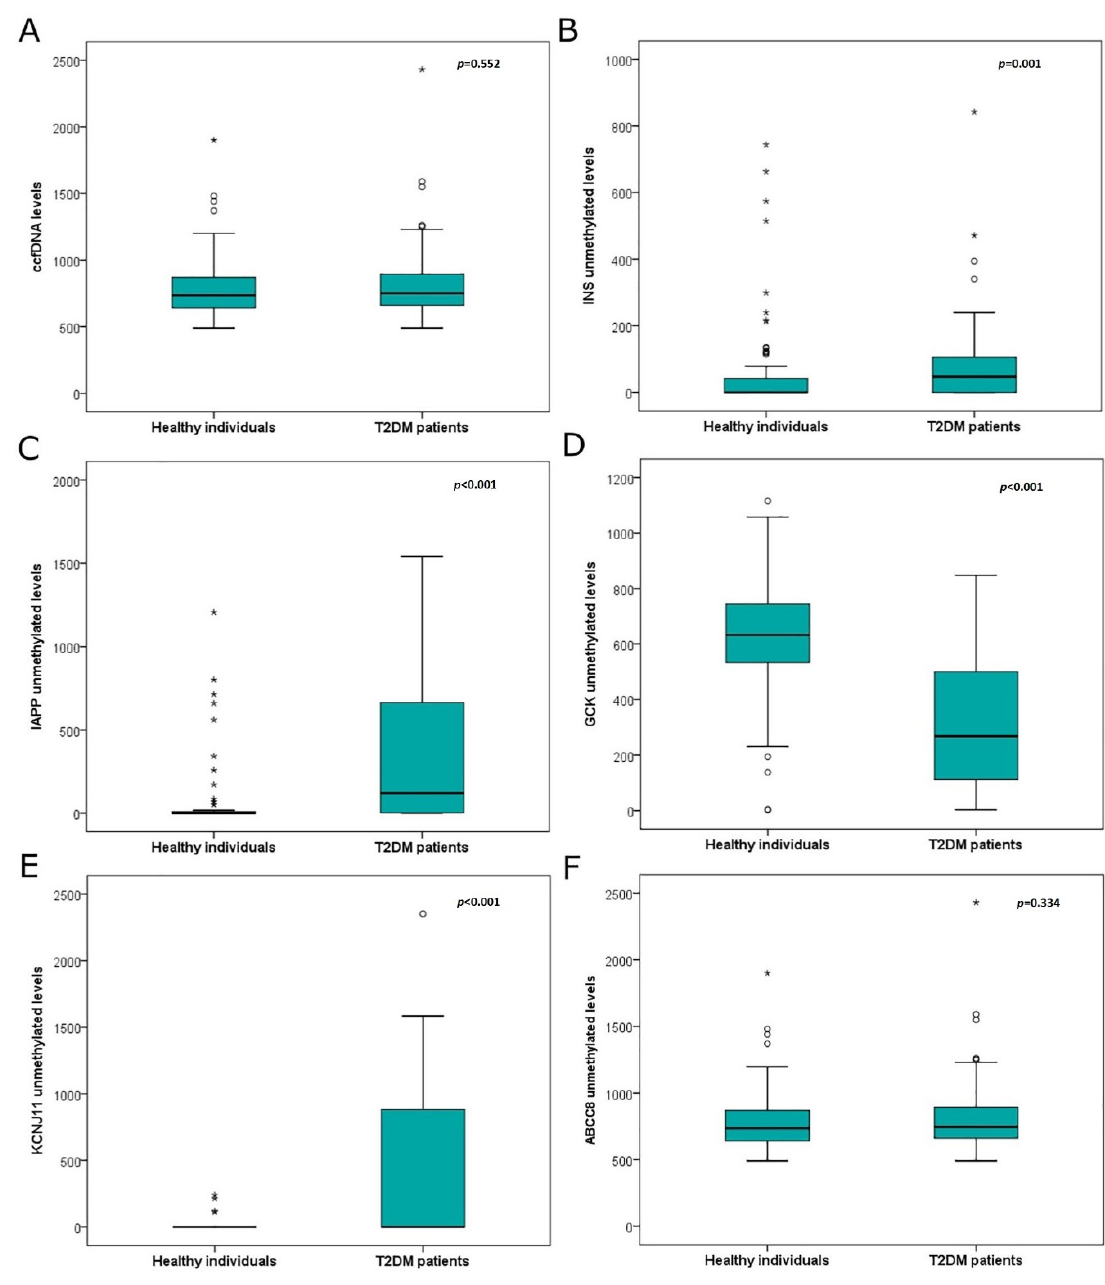
( p = 0.037). In Figure 3, representative electropherograms from two T2DM patients and one healthy individual are presented, showing a different pattern.